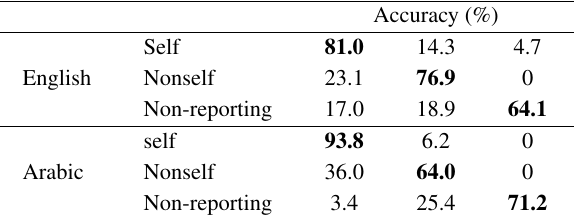
Table 9 Accuracy of classification by repTweets.